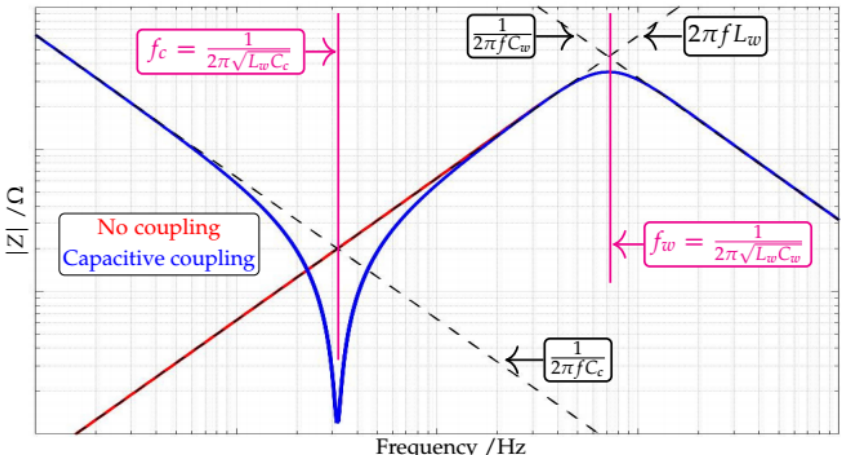
Figure 2. Coupling “shadow” over measured impedance spectrum —Redraw based on [26].